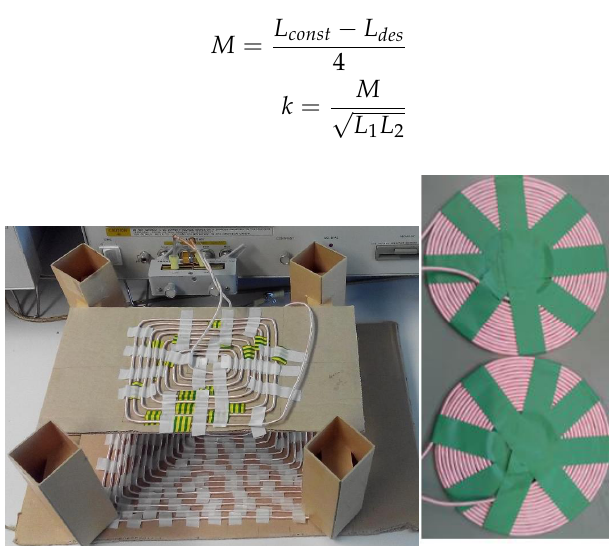
Figure 7. Experimental comparison of rectangular and circular coils with parameters as tabulated in Table 1.